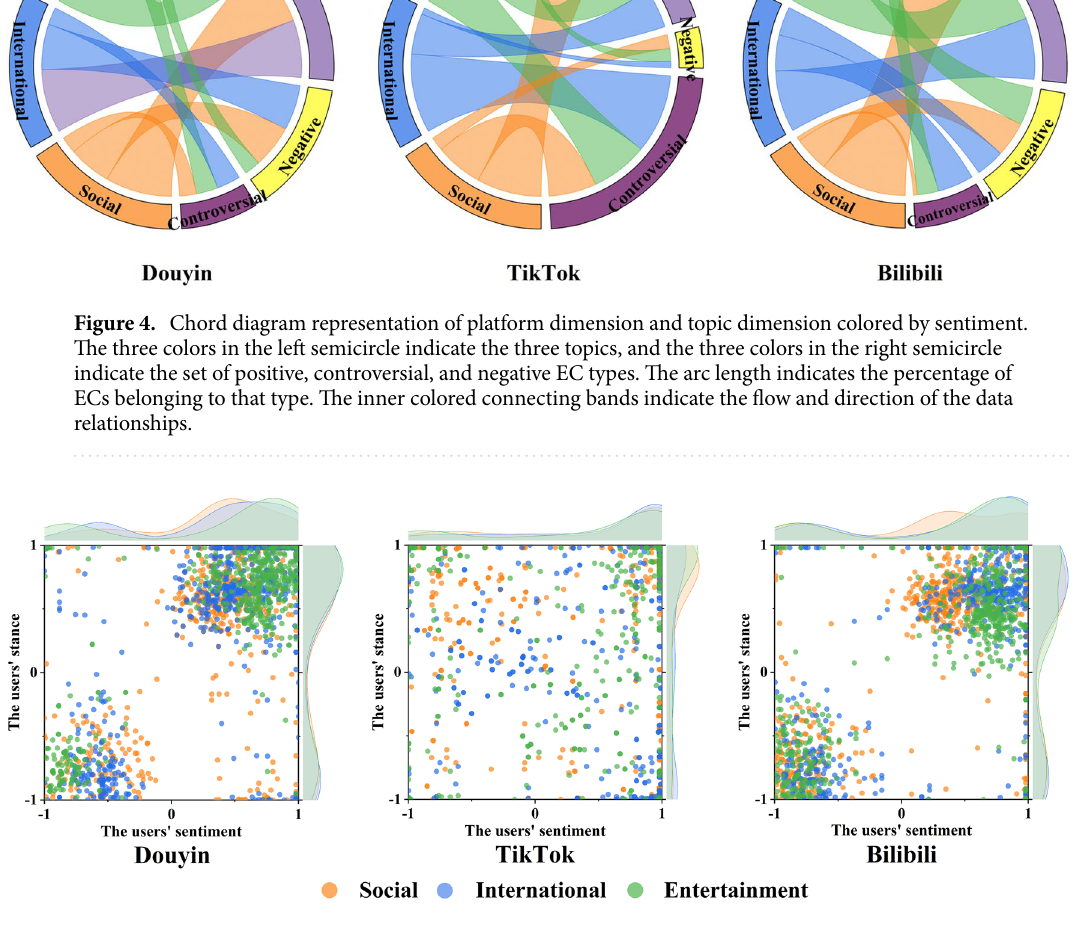
Figure 5. The distribution of users’ sentiment polarity in platform and topic dimensions. The X-axis indicates the user’s sentiment score in the same EC, while the Y-axis indicates the user’s stance